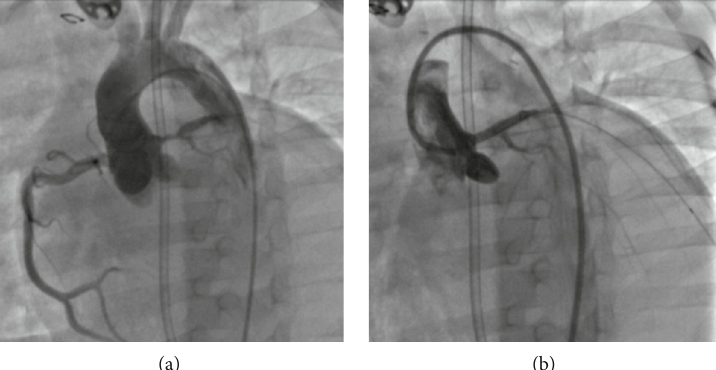
Figure 1: On the left-hand-sided panel (a), the angiography reveals a signi fi cant stenosis of the left main coronary artery. The right-hand- sided panel (b) depicts an excellent angiographic result after stent implantation in the left main coronary artery, which is now widely